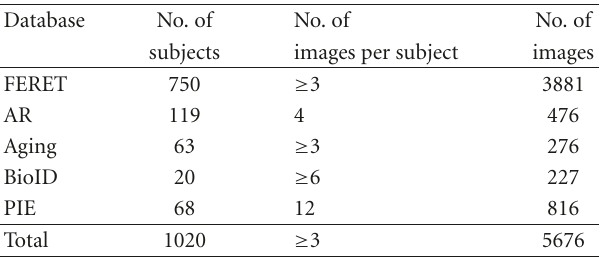
Table 1: Generic data set